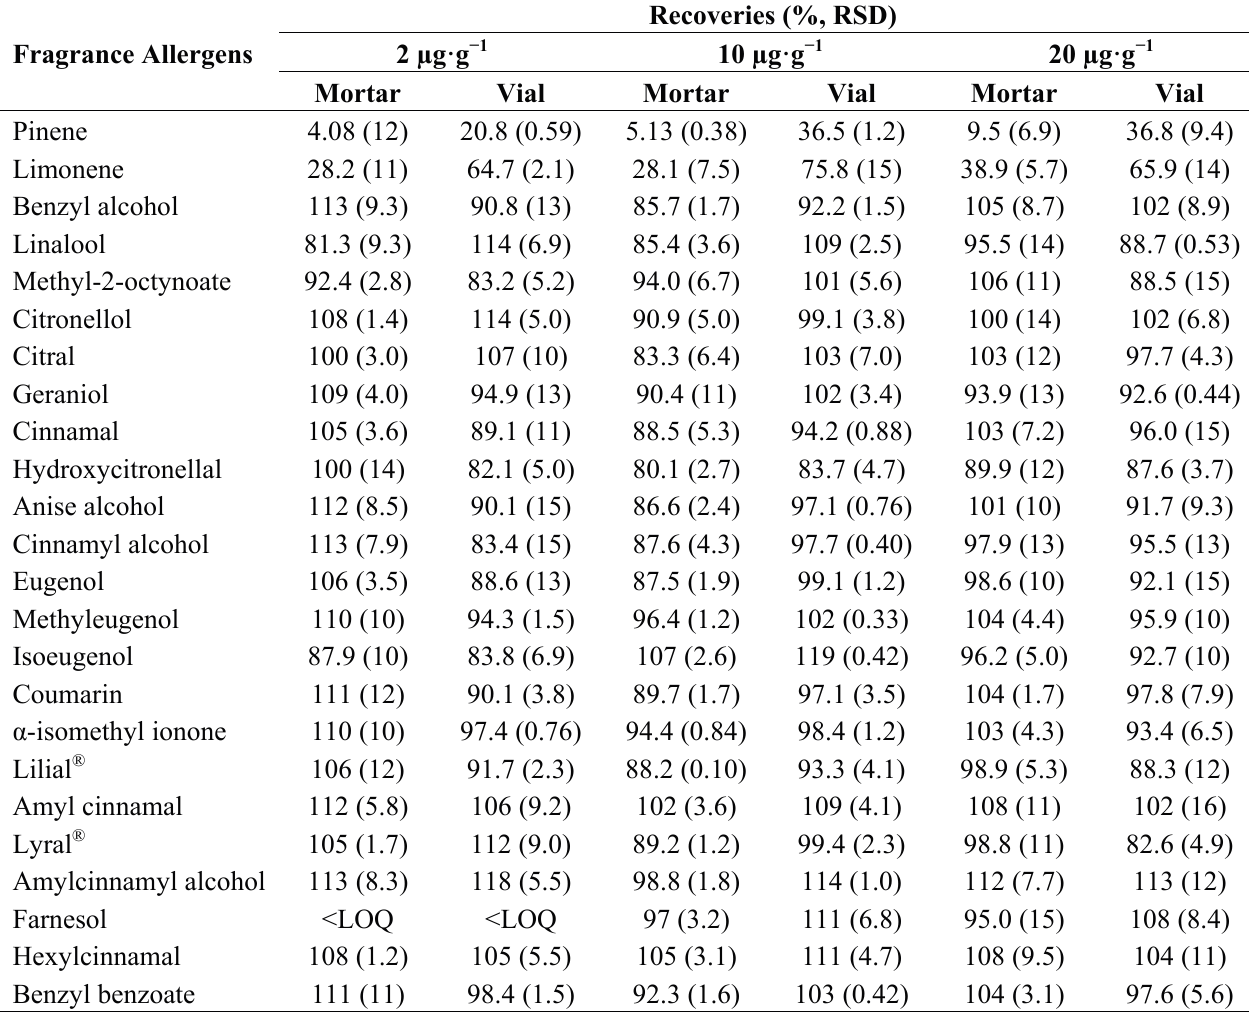
Table 5. Recoveries of fragrance allergens, preservatives, plasticizers and musks in a rinse-off sample (shampoo) fortified at three concentration levels, analyzed by the proposed method